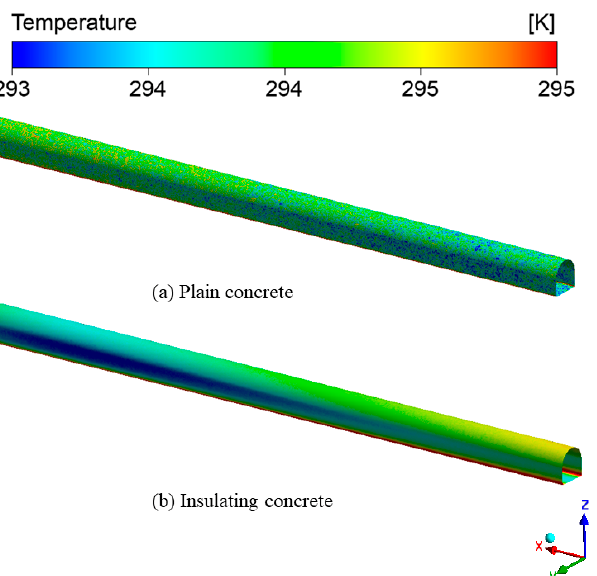
Figure 17. Temperature distribution on the wall of the roadway: ( a ) Temperature distribution on the wall of the roadway under plain concrete support; ( b ) Temperature distribution on the wall of the roadway under insulated concrete support.